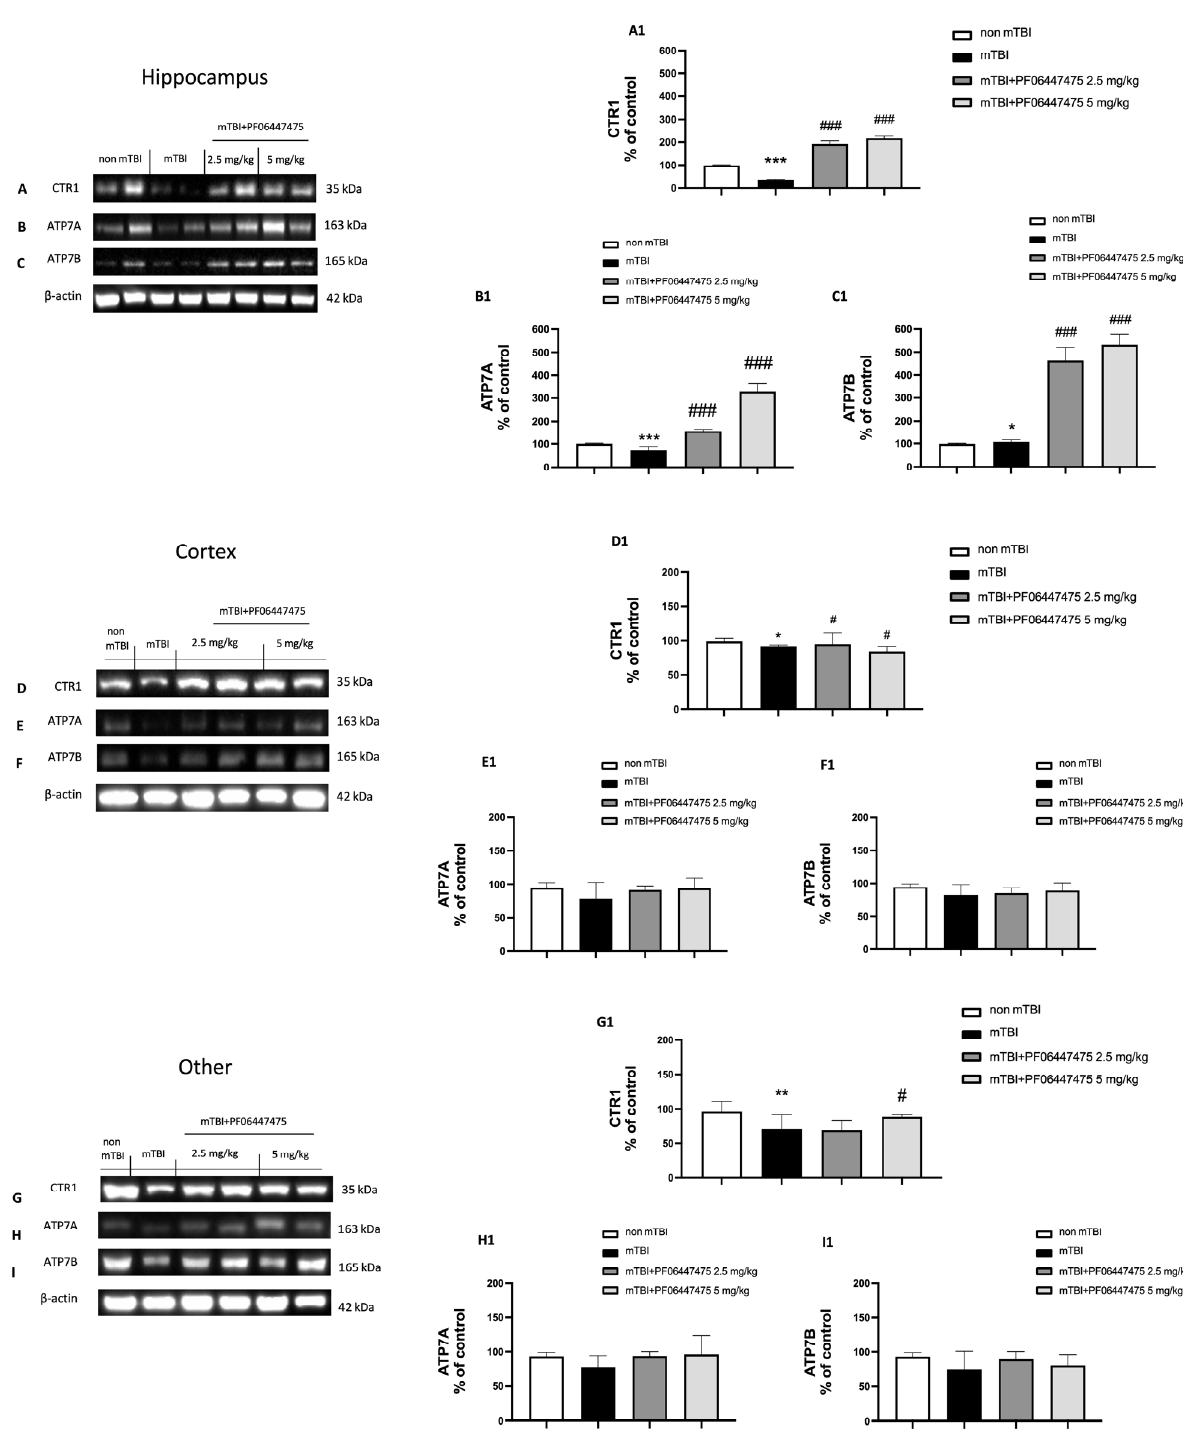
Figure 5. Effects of PF-475 on copper transporters expression after mTBI in hippocampus, cortex and other. Cytosolic fractions of hippocampus tissue were also used to evaluate copper transporters expression, such as CTR1, ATP7A and ATP7B. Representative blots of CTR1, ATP7A and ATP7B are shown ( A – C ), see densitometric analysis ( A1 – C1 ). Cytosolic fractions of cortex tissue: representative blots of CTR1, ATP7A and ATP7B are shown ( D – F ), see densitometric analysis ( D1 – F1 ). Cytosolic fractions of other tissue: representative blots of CTR1, ATP7A and ATP7B are shown ( G – I ), see densitometric analysis ( G1 – I1 ). Two-way ANOVA test. * p < 0.05, ** p < 0.01 and *** p < 0.001 vs. non mTBI; # p < 0.05 and ### p < 0.001 vs. TBI.